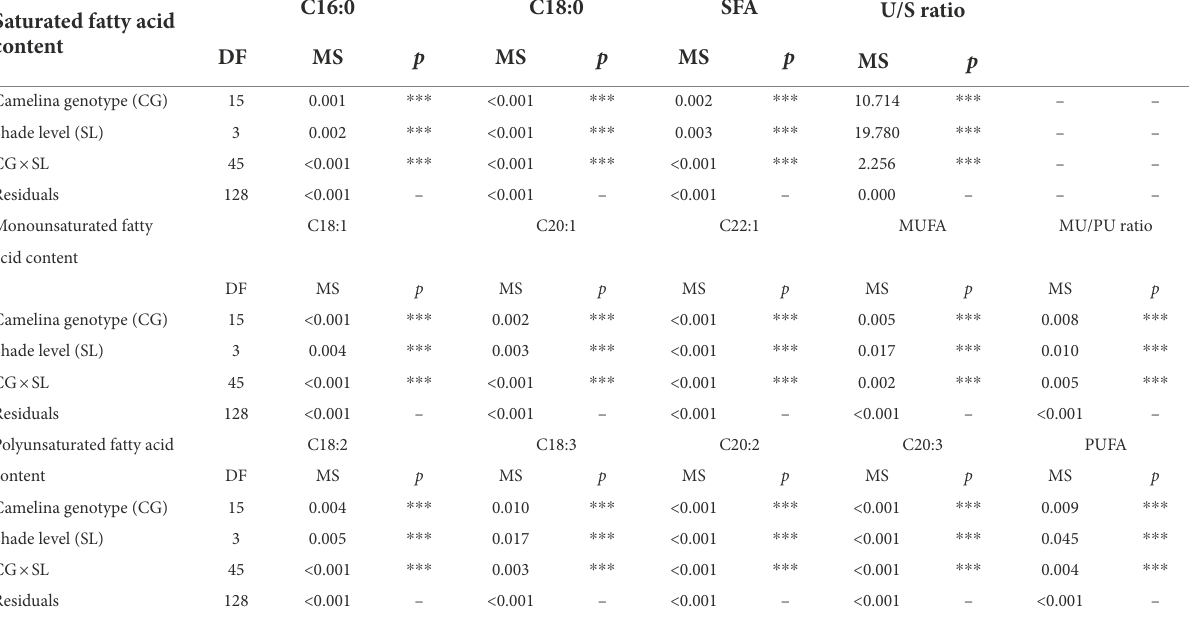
TABLE 3 Effect of fixed sources of variation on camelina seeds of principal fatty acid contents, fatty acid group contents and fatty acid ratios grown under different shade treatments. Source Saturated fatty acid